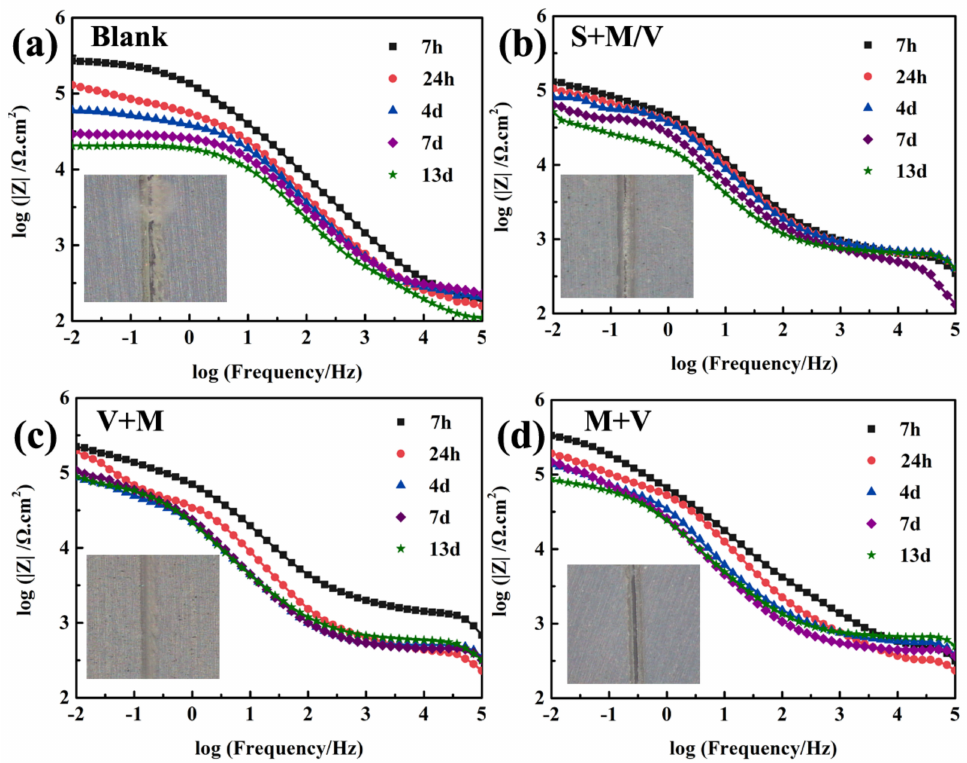
Figure 9. The evolution of Bode plots and optical photographs of scratched coatings immersed in a 0.05 M NaCl solution for 13 days: ( a ) Blank coating, ( b ) S + M/V coating, ( c ) V + M coating, and ( d ) M + V